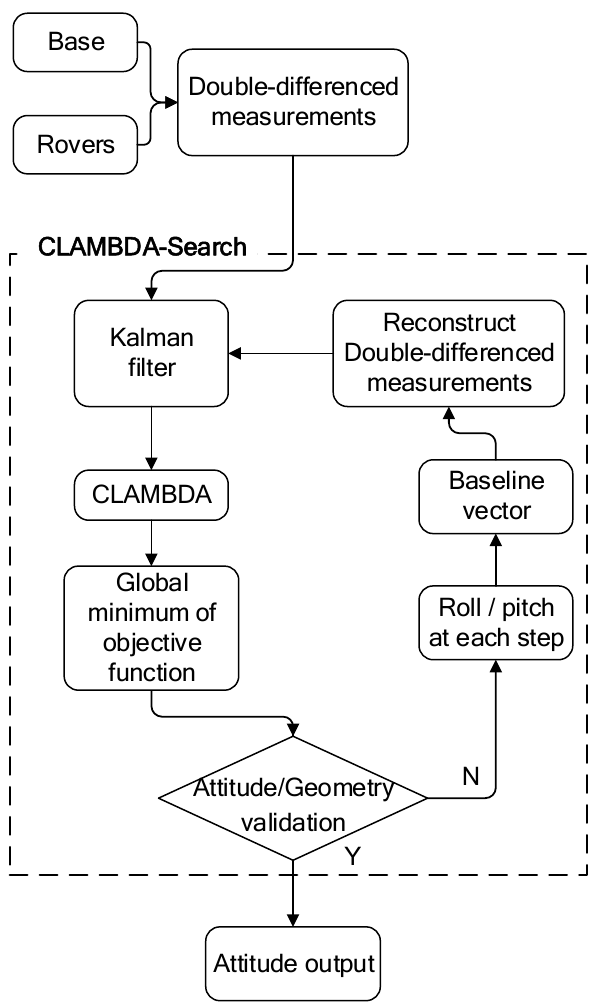
Figure 2. Procedure of CLAMBDA-search method for attitude determination.